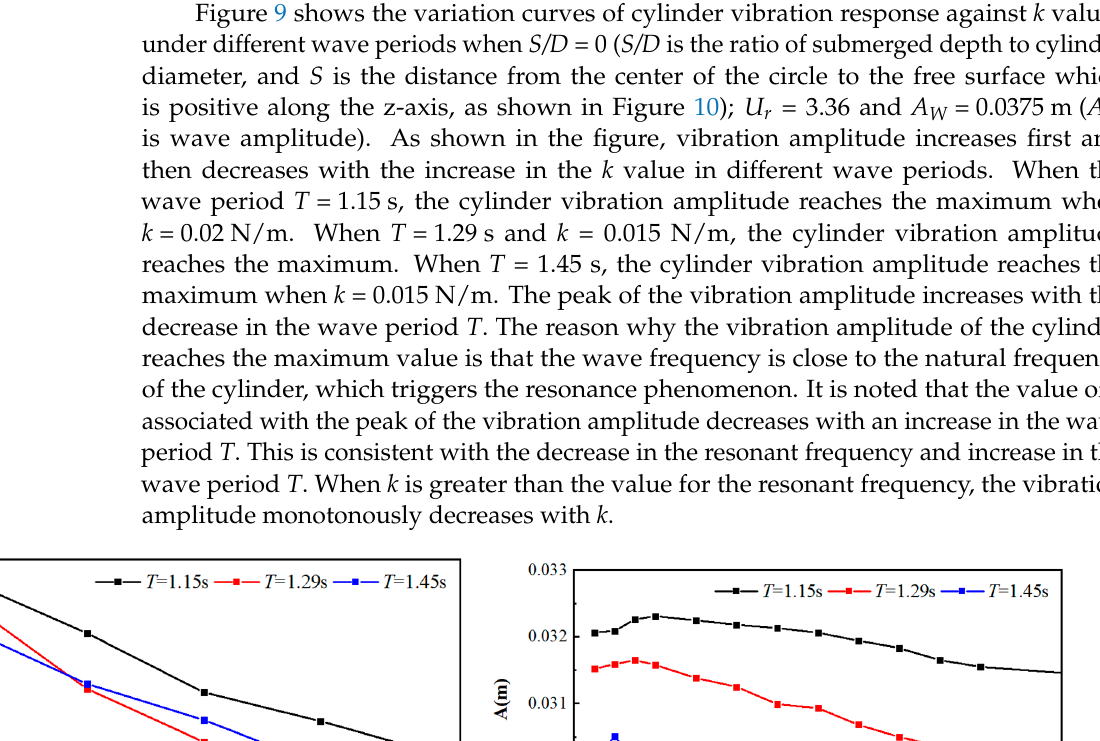
Figure 10. S/D diagram. 4.1.2. Vibration Responses under Different Submerged Depth Figure 11 shows the variation curves of cylinder vibration response against k values under different submerged depths when T = 1.29 s, U r = 3.36, and A W = 0.0375 m. As can be